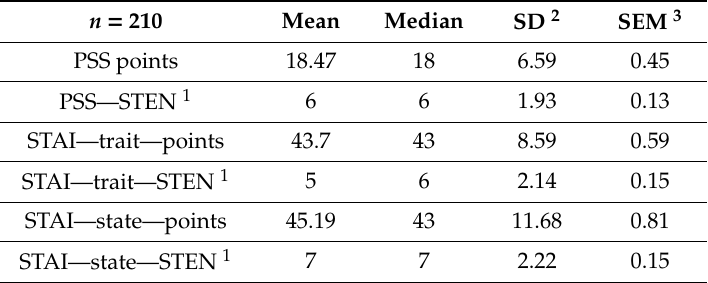
Table 1. Results’ summary.